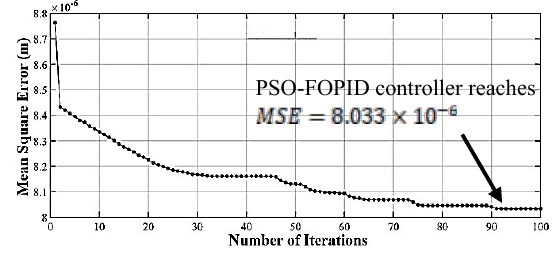
Figure 6. Convergence curve of the fitness function, MSE